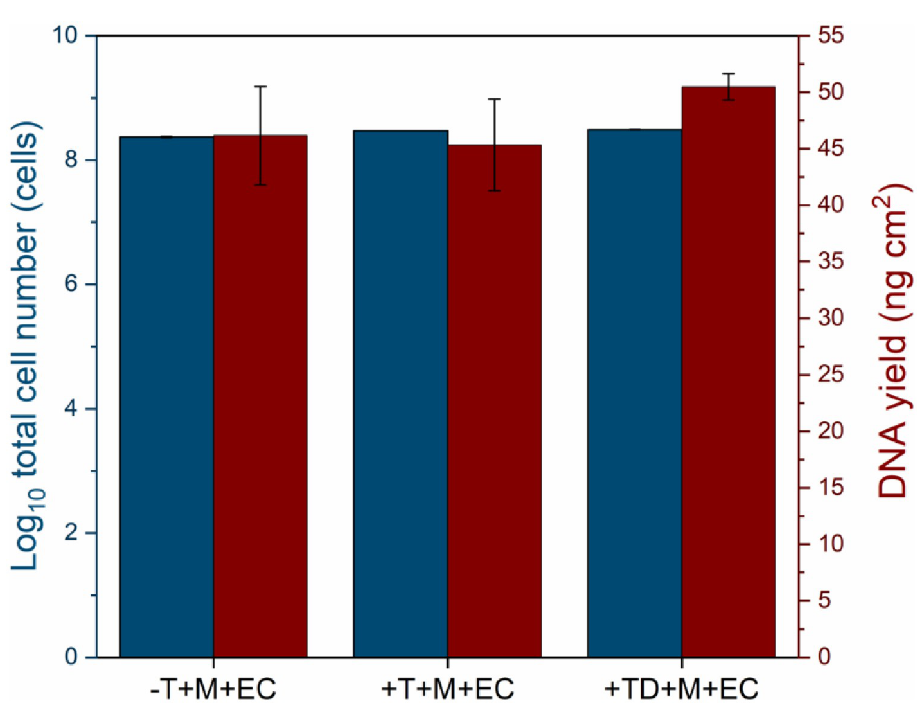
Fig 5. Total cells and DNA yield obtained from spiking onto membrane filters without and after tap water (T: Tap water with residual chlorine and TD: Dechlorinated tap water) filtration. The details for membrane spiking treatments are summarized in Fig 2. T: Tap water containing residual chlorine. TD: Tap water with the removal of residual chlorine (addition of SMBS 10% (v/v)).–T + M + EC: Membrane spiked with E . coli only (without tap water filtration). +T + M + EC: Membrane spiked with E . coli after tap water (with residual chlorine) filtration. +TD + M + EC: Membrane spiked with E . coli after tap water (dechlorinated) filtration. The error bars show errors from triplicate